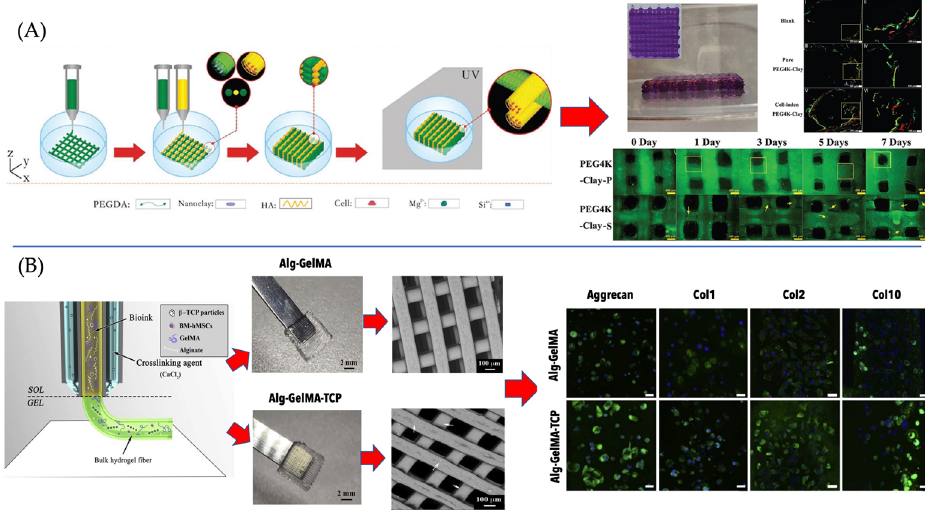
Figure 2. ( A ) Schematic depicts the fabrication technique and the biological response of bioinks comprising poly(ethylene glycol) diacrylate (PEGDA), hyaluronic acid (HA), and laponite (nanoclay) designed for bone tissue engineering; ( B ) displays the preparation of 3D ‐ bioprinted scaf ‐ folds containing alginate, GelMA, and beta ‐ TCP for cartilage regeneration (adapted with permission from [35,180], 2022, IOP Publishing, Wiley VCH Verlag GmbH & Co